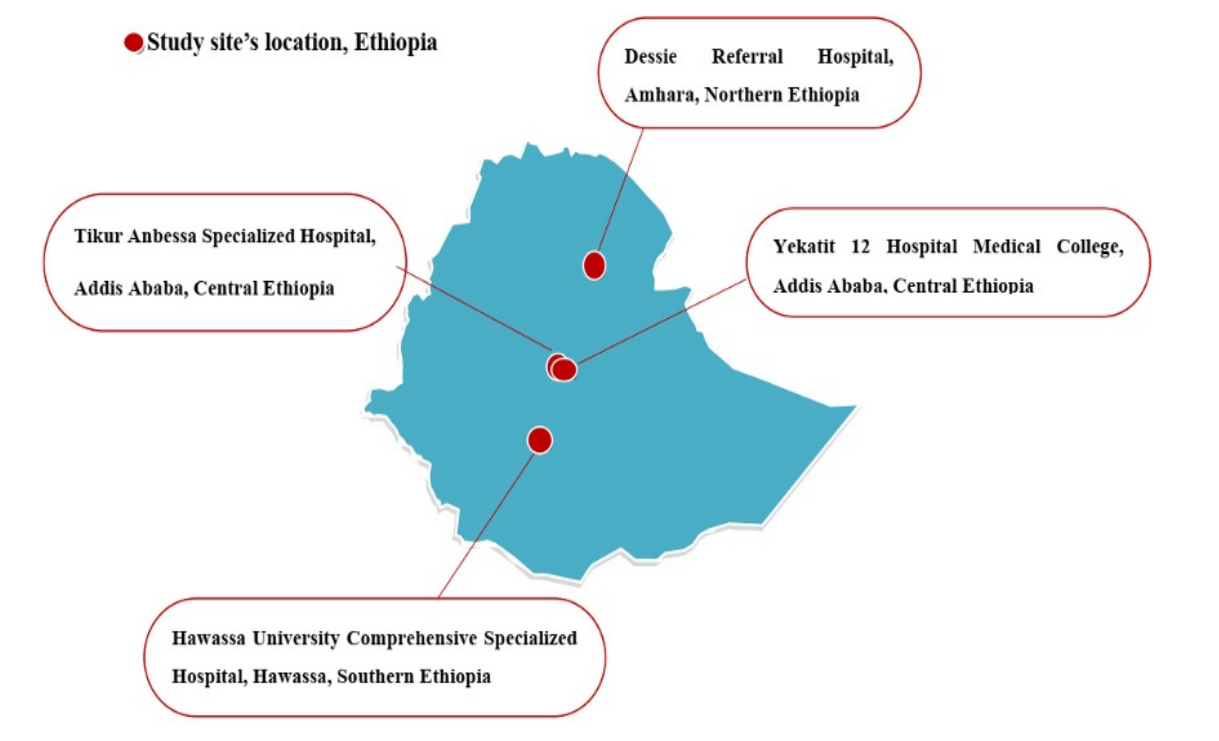
Figure 5. The four Ethiopian referral hospitals selected for this study and from where Enterobacteri- aceae were isolated. TASH, located in Addis Ababa, is the teaching hospital of Addis Ababa University and the largest referral and oldest hospital in the country. It provides tertiary level referral diagnoses and treatment for patients referred from all over the country with over 800 beds. DRH is one of the largest public hospitals in the northern part of Ethiopia, located in Dessie. It is a referral hospital with 560 beds, providing services for the surrounding areas and residents of the neighboring regions. Y12HMC is located in Addis Ababa and provides health care services to Addis Ababa residents, referral cases from health centers in Addis Ababa and its bordering regions. The hospital has over 300 beds and serves more than 5 million people in its catchment area. HUCSH, located in Hawassa city, is one of the largest health facilities in the southern part of the country and provides teaching, public health services and research activities with over 400